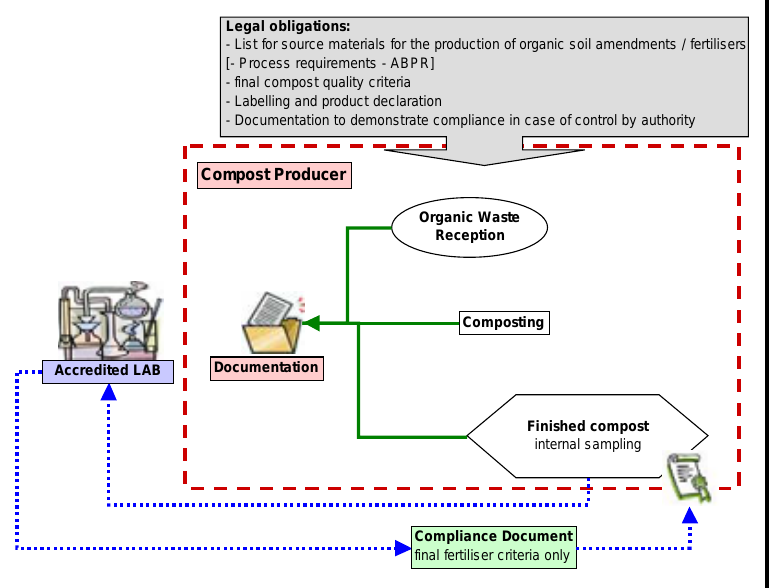
Figure 16: Simple registration regime e.g. with a national fertiliser ordinance without regular 3 rd party approval of compost production and documentation Member States for which this regime applies: CZ, DK, ES, FR, HU, IE, LV, NL,